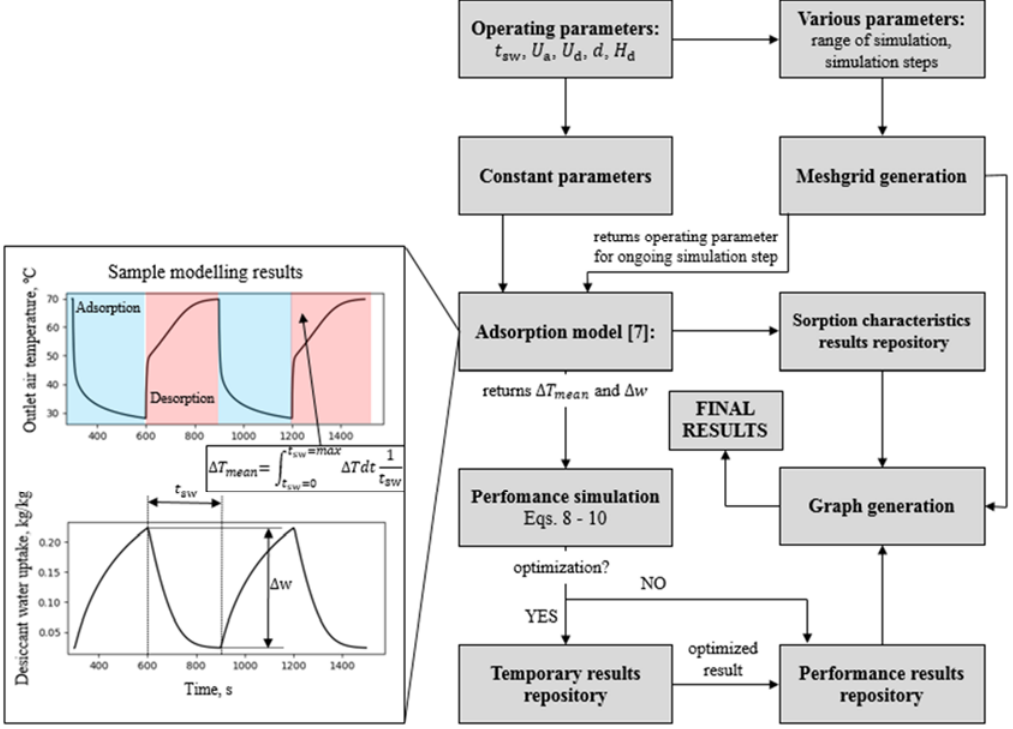
Figure 2. Description of the simulation procedure.